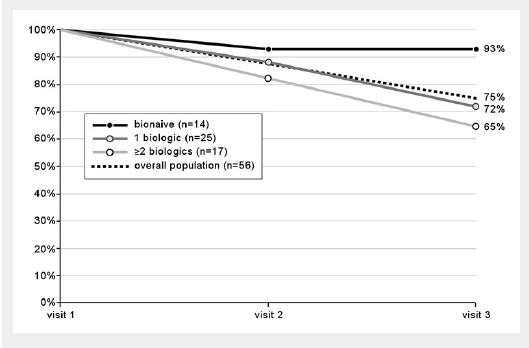
Drug retention over time: percentages of patients still on treatment at visits 2 and 3 (numbers in brackets indicate the population size at visit 1).